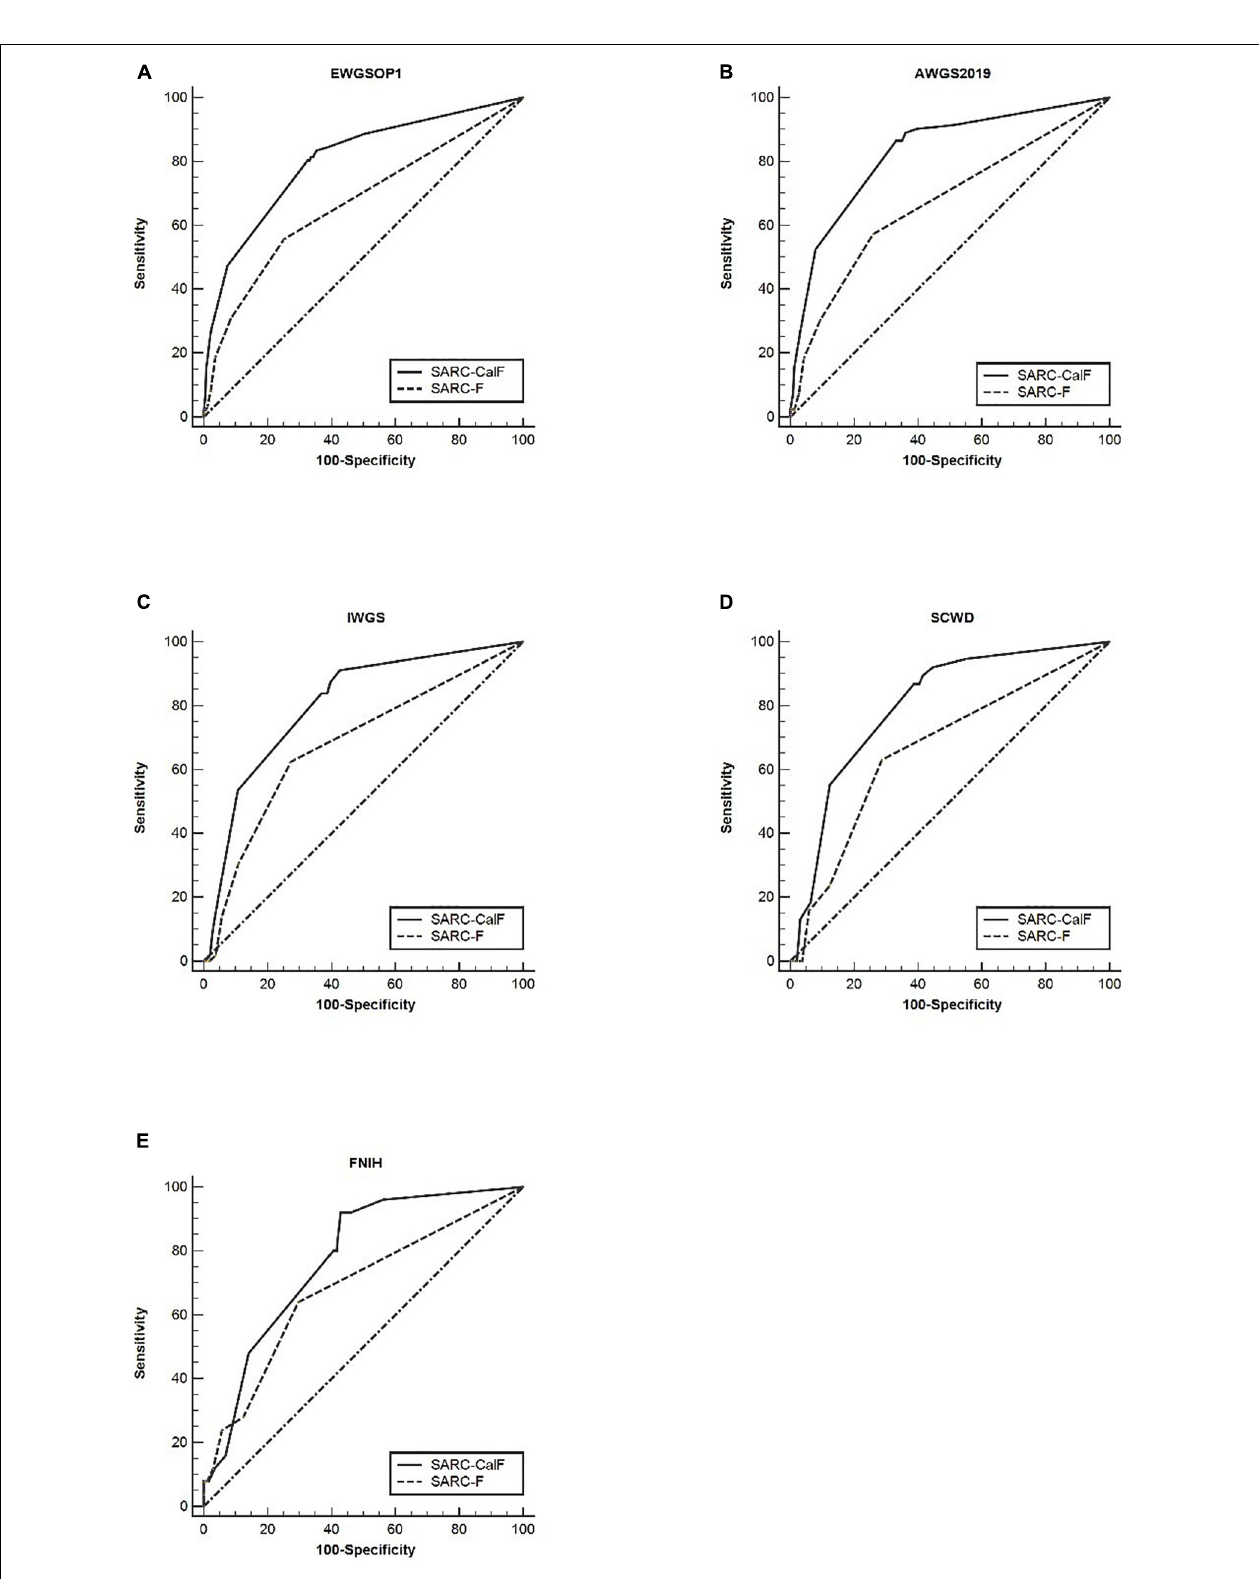
FIGURE 2 | The ROC curves of SARC-F and SARC-CalF compared with various reference standards in men: (A) sarcopenia according to the EWGSOP1 criteria; (B) sarcopenia according to AWGS2019 criteria; (C) sarcopenia according to IWGS criteria; (D) sarcopenia according to SCWD criteria; and (E) sarcopenia according to FNIH